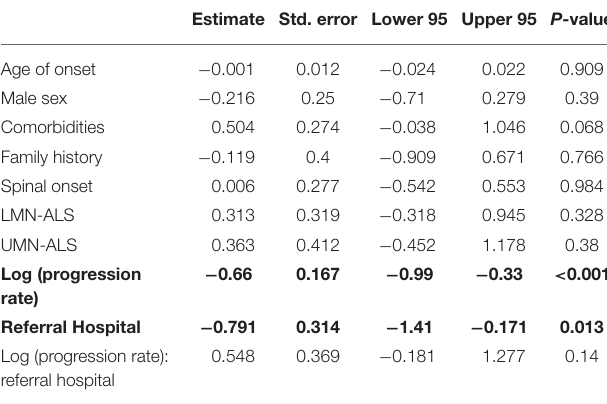
TABLE 3 | Multivariable model assessing the effect of several variables in the time neurologist-diagnosis. Estimate Std. error Lower 95 Upper 95 P